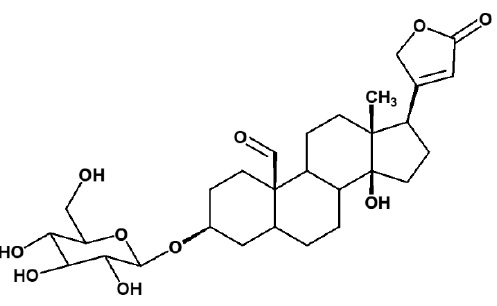
Figure 4. Cardenolide glycoside crotoxigenin 3- O -glucopyranoside ( 3 ), isolated from X. undulatum .